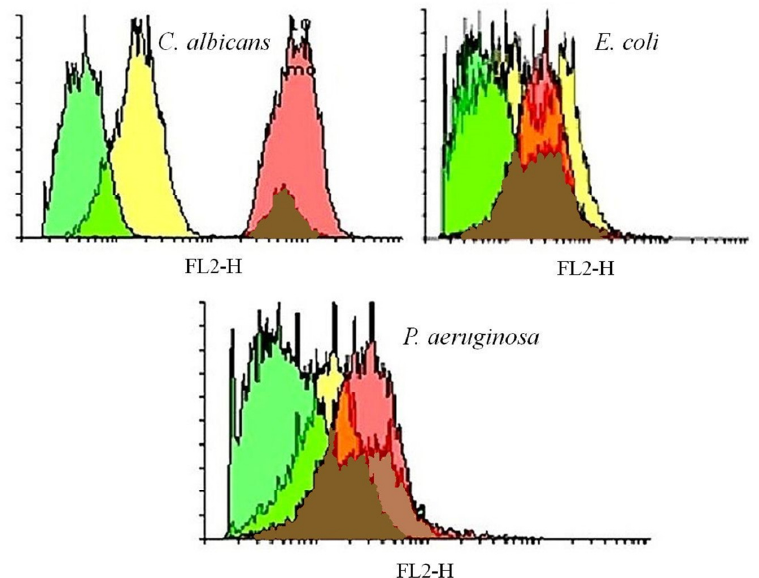
Fig. 1. Overlay of the histogram for the median of the fluorescence intensity of efflux pumps, viable cells control (green) and heat treated cells control (red), cells treated with O. europaea fatty oil (yellow); a, b, c - typical aspects of the histograms obtained at MIC/2 concentration values for tested bacteria